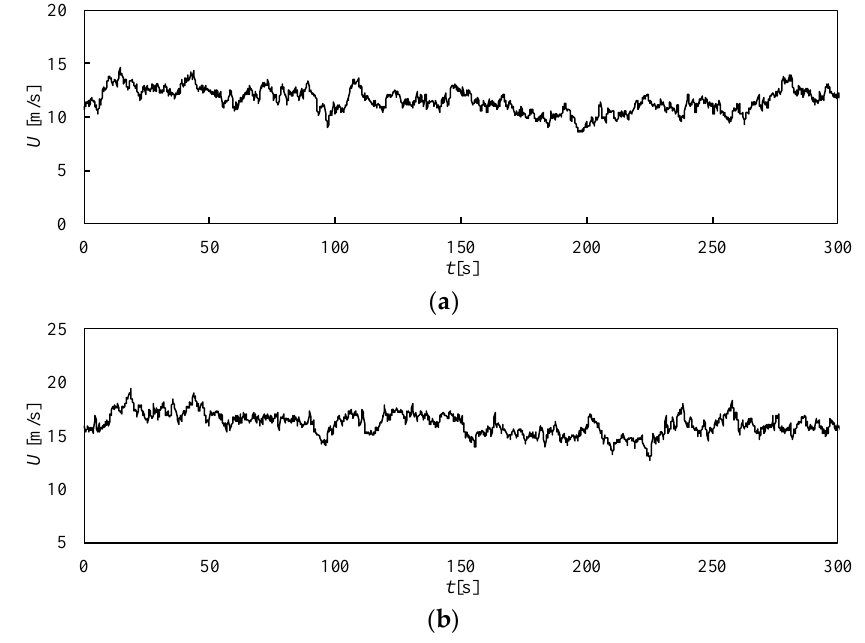
Figure 12. Axial velocities in turbulent conditions with a turbulence intensity of 9.58%. ( a ) The average